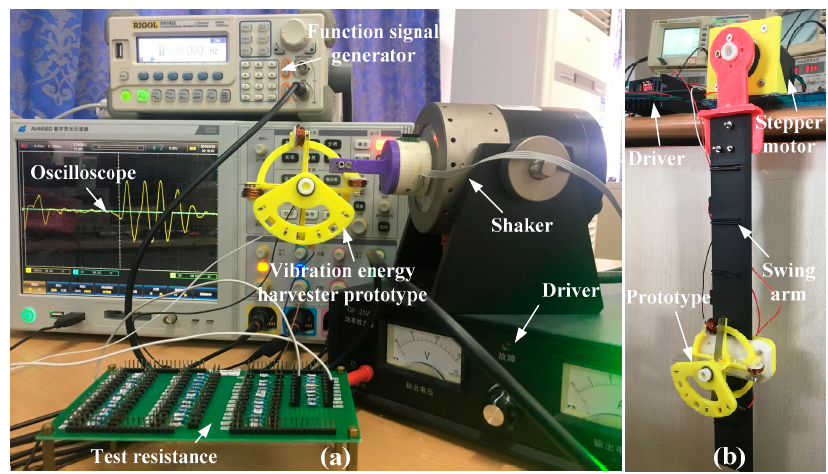
Figure 5. Experimental setup. ( a ) Single dimension vibration test platform. ( b ) Swing device for simulating the swing of human arm.